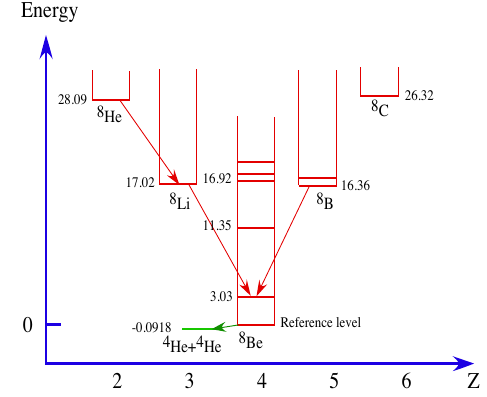
Figure 3: The relative energies of the ground states Figure 8.3: The energy levels of the nuclear system of the N+Z=8 nuclei. The numbers are the energies in with A=8 for di↵erent atomic numbers Z . The nu- MeV relative to the ground state of 8 Be, which has the cleus 8 B can decay into an excited state of 8 Be , which lowest ground state energy of all A=8 nuclei. However, may decay eventually to the 8 Be ground state. But the state of two free α ’s has still lower energy. Hence, the ground state of 8 Be is above the state of two free there is no stable nucleus with A=8. ↵ particles (colored green) and hence, the fast break- down of 8 Be is unavoidable. Consequently, 8 Be does not exist in nature.